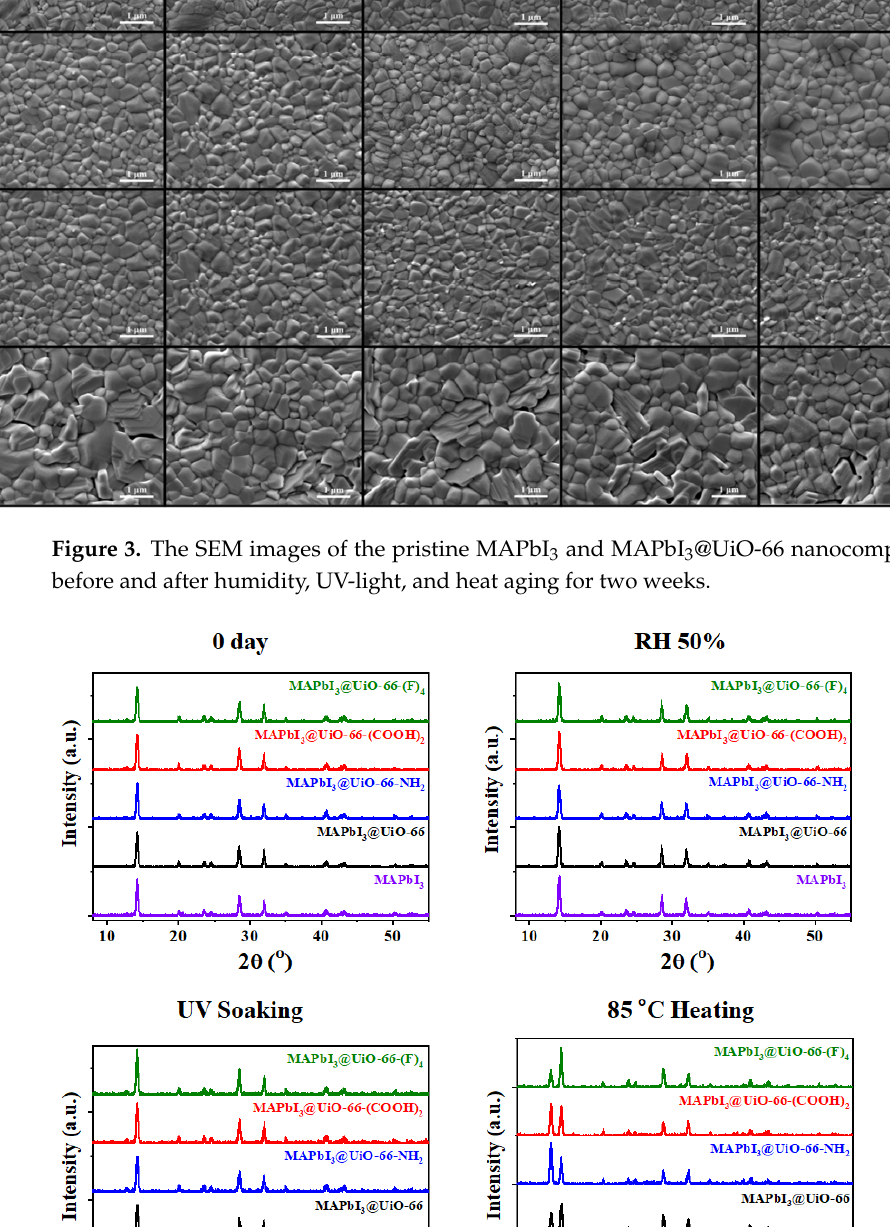
Figure 5. Schematic of the interaction of perovskite/UiO-66 and perovskite/UiO-66-(F) 4 . We next analyzed the UV-Vis absorption of these samples before and after aging. Specifically, we recorded and traced the characteristics of the band-edge absorption, PL intensity, and its peak shift to examine the difference caused by aging [38,39]. Figure 6 displays the UV-Vis spectra of the pristine MAPbI 3 and MAPbI 3 @UiO-66 nanocomposite samples before and after humidity, UV-light, and heat exposure for two weeks. Consistent with the aforementioned results, the samples retained the unique dark brown color of perovskite without showing a distinguishable difference, except for the heat-aged sam- ples. The UV-irradiated and humidity-aged samples possessed sharper absorption edges, which represented a lower band-tail recombination. This can be attributed to the age-in- duced recrystallization, as discussed earlier [36]. On the other hand, the heat-aged